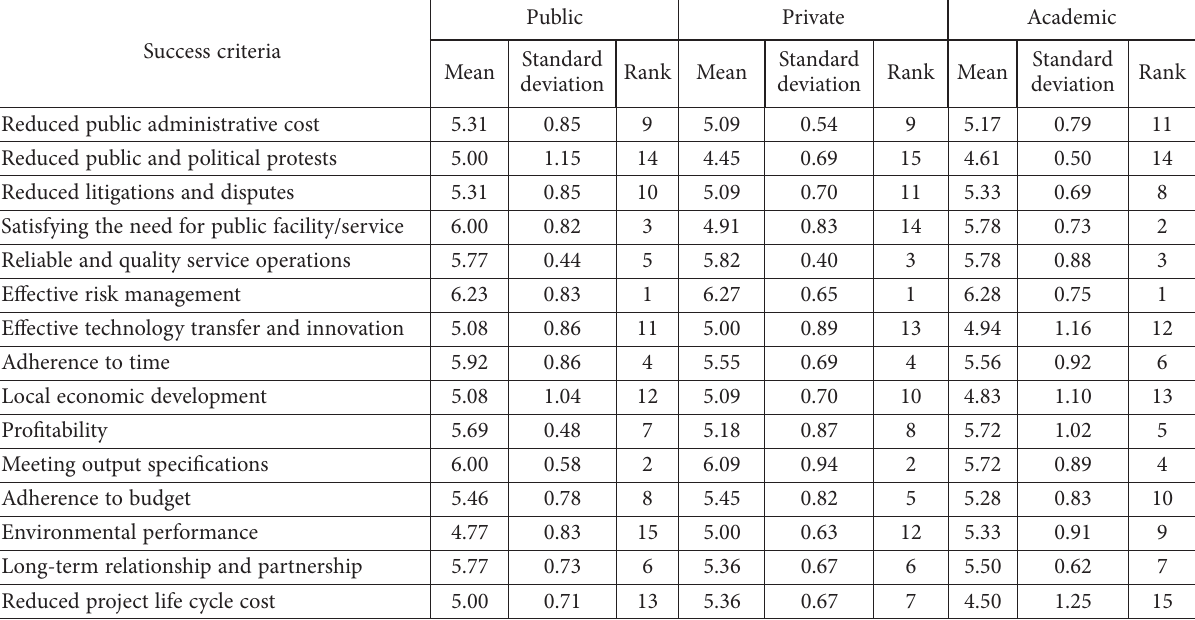
Table 5. Mean scores and rankings of the success criteria for PPP projects by public, private and academic sectors